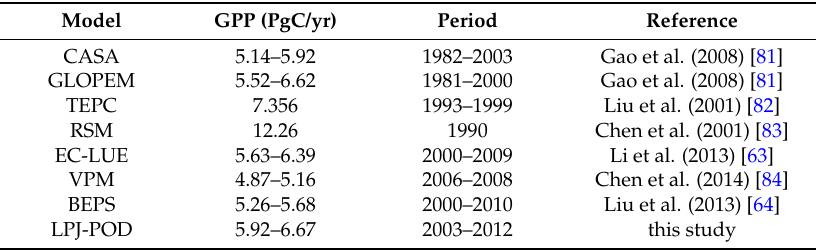
Table 4. Estimation of total gross primary productivity (GPP) values in China with different terrestrial